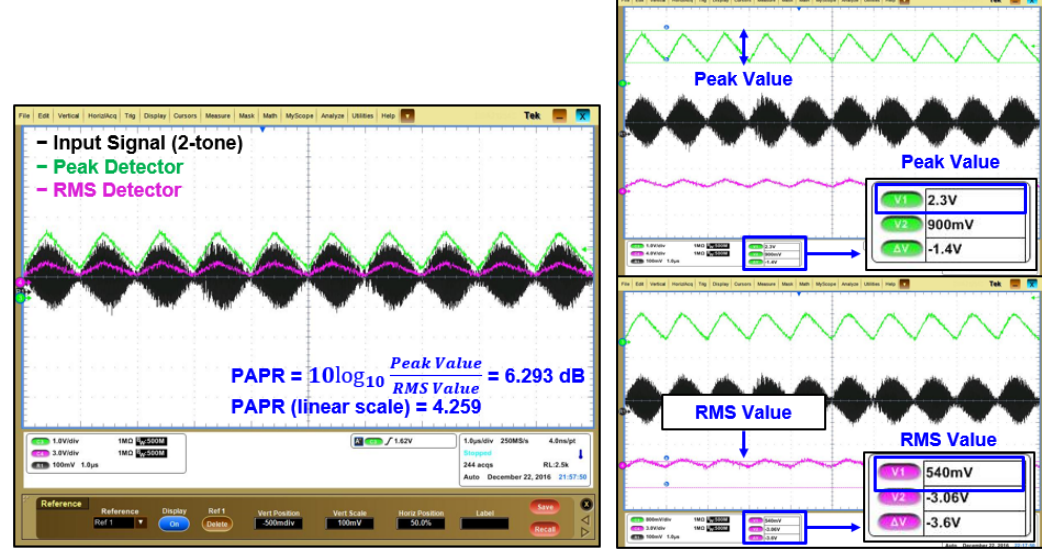
Figure 18. Measurement results of 2-tone PAPR path.